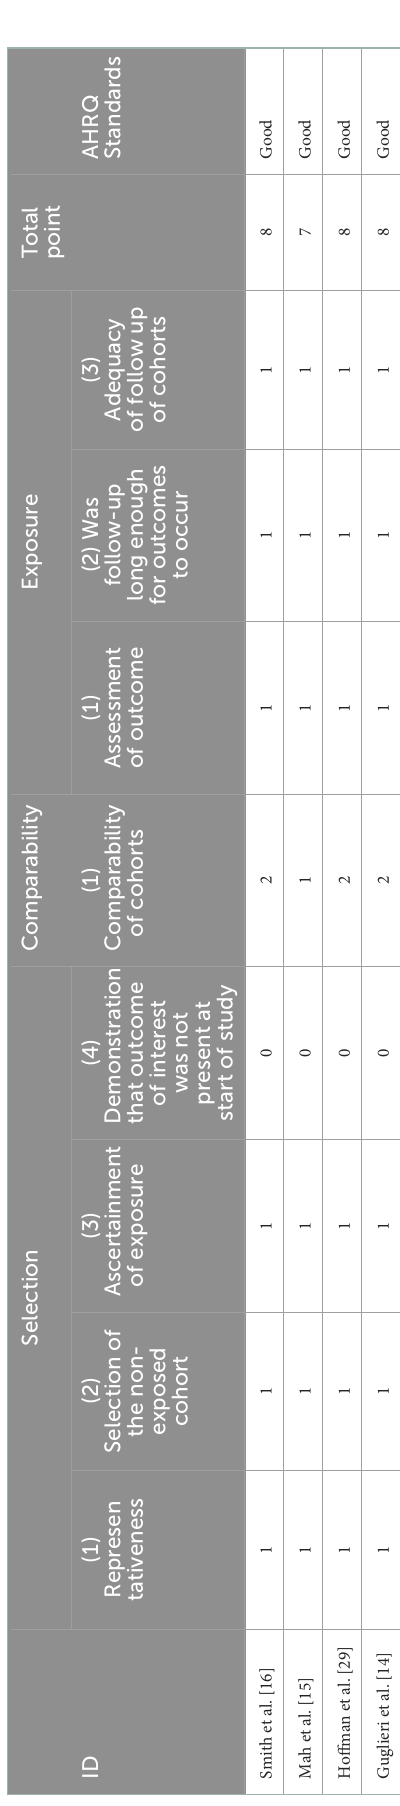
TTSTAND velocity The pooled analysis showed no statistically significant difference oo d between the vamorolone group and the Glucocorticoid group (MD G = 0.00, 95% CI = − 0.08–0.09, p = 0.94). We observed a significant heterogeneity between the two studies ( P = 0.02, I² = 83%, Figure 5). TTRW velocity The pooled analysis showed a statistically significant association between the vamorolone group and increased TTRW velocity compared with the glucocorticoid group (MD = − 0.14, 95% CI = − 0.26 to − 0.01, p = 0.03). We observed no significant heterogeneity between the two studies ( P = 0.26, I² = 20%, Figure 6). TTCLIMB velocity The pooled analysis showed no statistically significant difference between the vamorolone group and the glucocorticoid group (MD = − 0.03, 95% CI = − 0.06–0.01, p = 0.12). We observed no significant heterogeneity between the two studies ( P = 0.36, I² = 0%, Figure 7).